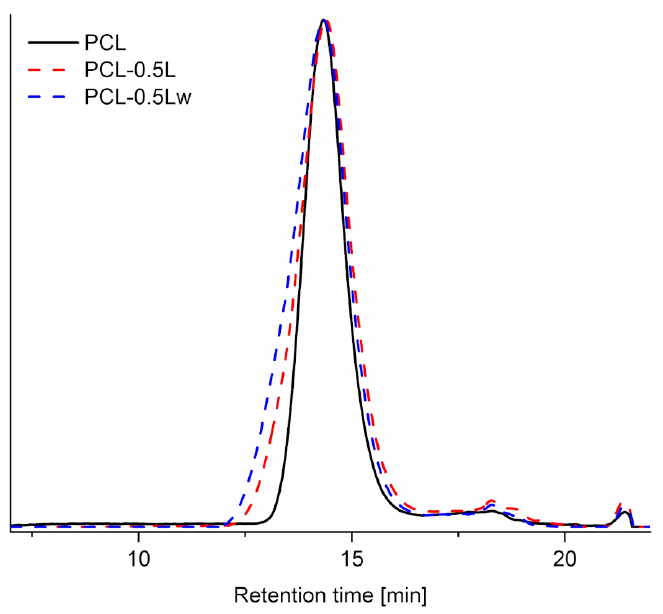
Figure 2. SEC chromatograms of fractions completely soluble in chloroform of PCL and PCL reacted with 0.5 wt.% peroxide during dry (PCL-0.5L) or water-assisted (PCL-0.5Lw) REx. (cid:0) (cid:1) M w Table 1. Number ( M n ) and weight average molecular weights rounded off and dispersity (Ð) detected from SEC of fractions completely soluble in chloroform of PCL and PCL reacted